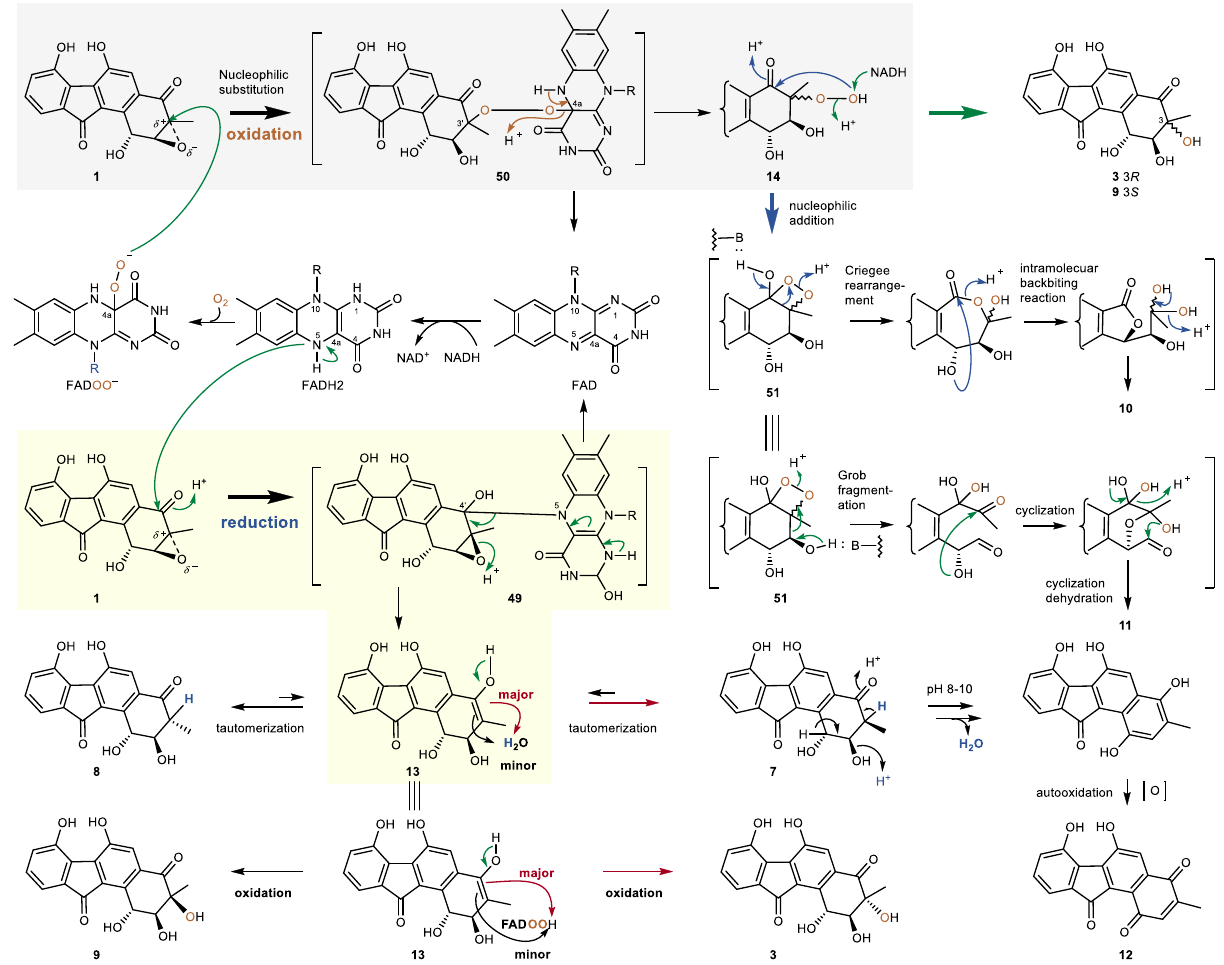
13 , which can undergo tautomerization to yield 7 (major) or 8 (minor), and oxi- dation to produce 3 (major) or 9 (minor). 7 can be further autooxidized to 12 . Whereastheoxidativeringopeningislikelytoinvolvea fl avinC4a ‒ O ‒ O ‒ C3 ′ adduct ( 50 )togivetheperoxylatedintermediate 14 (graybackground),whichcanundergo reduction to 3 and 9 by NADH, and further rearrangements leading to 10 and 11